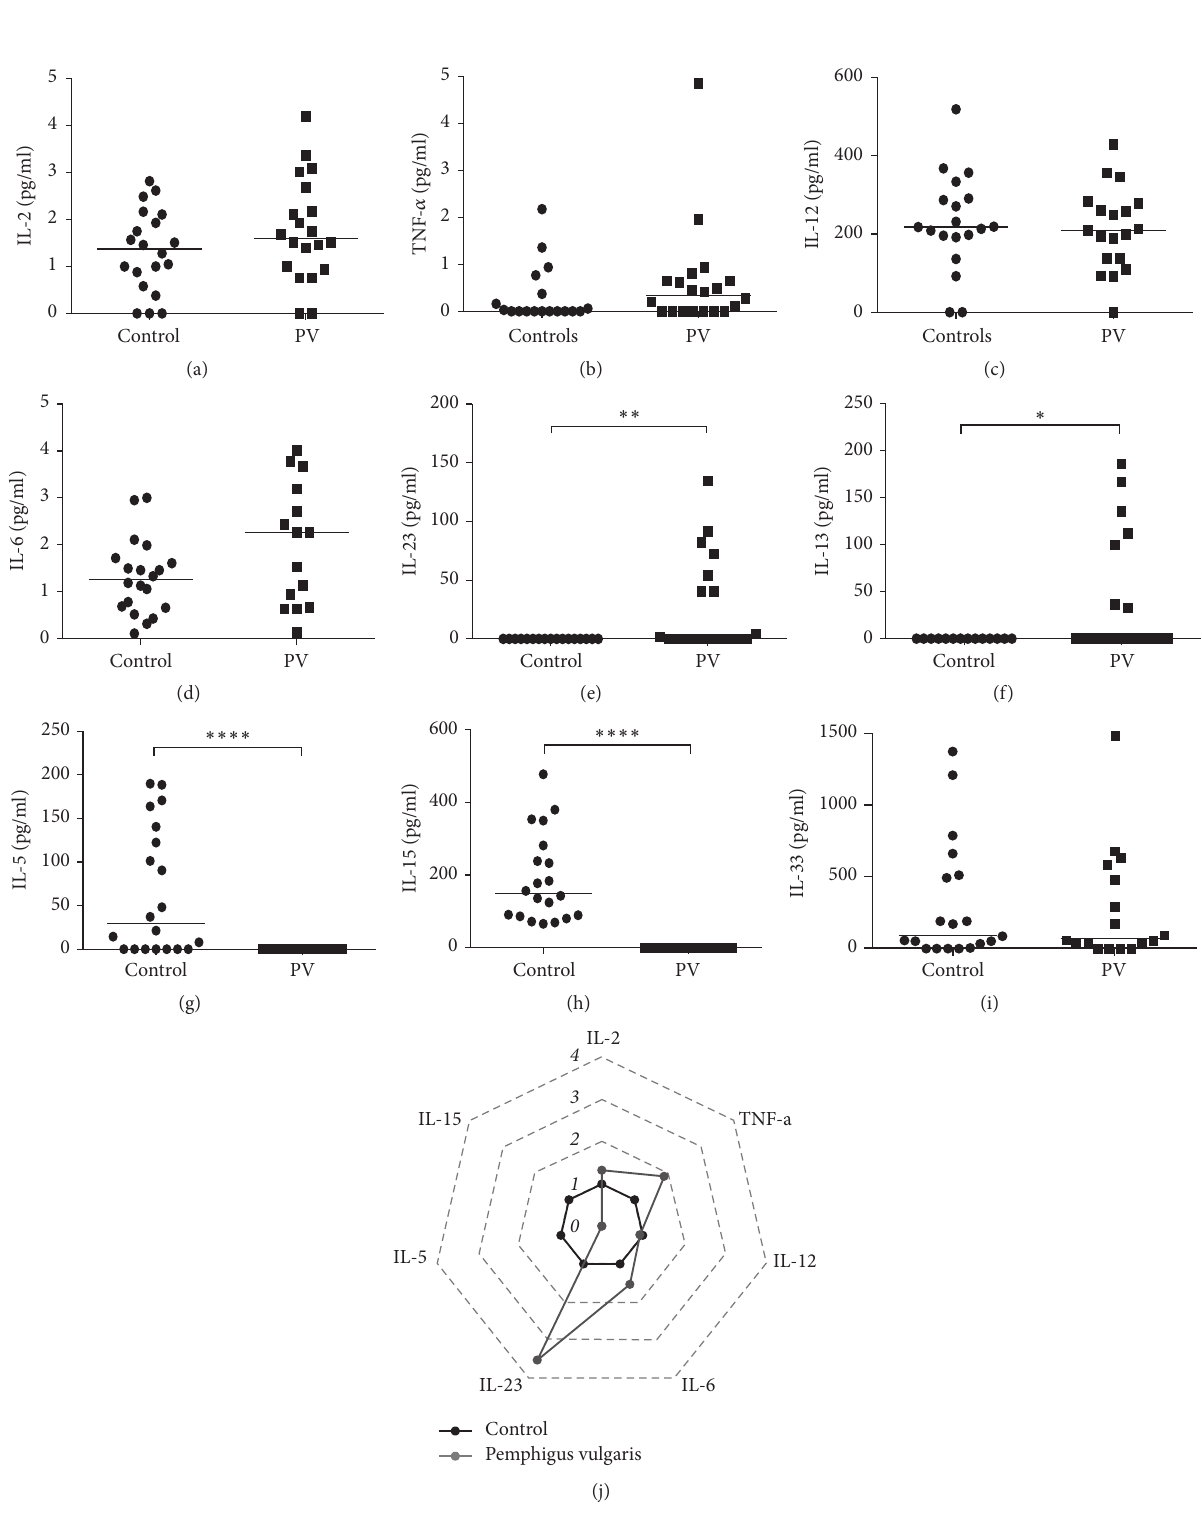
Figure 2: Serum profile of other proinflammatory cytokines in Pemphigus vulgaris. Levels of (a) IL-2, (b) TNF- 𝛼 , (c) IL-12, (d) IL-6, (e) IL-23, (f) IL-13, (g) IL-5, (h) IL-15, and (i) IL-33 in Healthy Donors ( (cid:2) ) and Pemphigus vulgaris patients ( ◼ ). Error bars represent median ± SD. ∗ 𝑝 < 0.05 ; ∗∗ 𝑝 < 0.01 ; ∗∗∗∗ 𝑝 < 0.0001 ; Mann–Whitney test. (j) Radar plot representation of serum proinflammatory cytokine profile. The lines highlight the fold change in cytokine levels in Pemphigus vulgaris patients (gray line) in relation to Healthy Donors (black line). Data were obtained by calculating the ratio between the median concentration of each cytokine in the Pemphigus vulgaris group and in the healthy